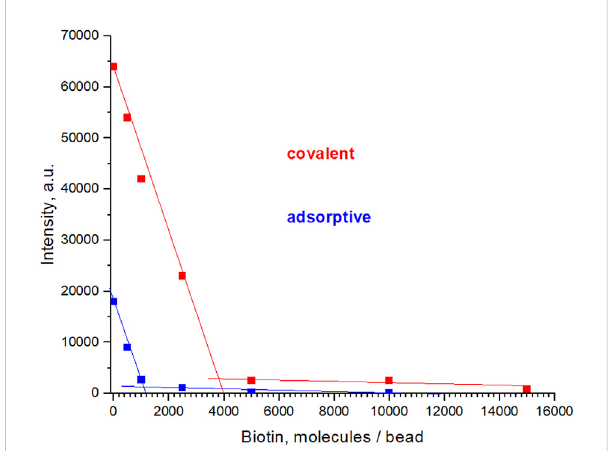
Fluorescence “ Microscopy-Titration ” : Results from lightness evaluation of the Biotin-testline of Lateral Flow strips after blocking theadherenceoftheanalyte(Neutravidin)withincreasingadditions of Biotine prior to the chromatography. Both, Neutravidin covalently and adsorptively coupled are represented. Each data point corresponds to one individual chromatography experiment. Samples evaluated were core-shell particles after method 1. Microscope settings: excitation at 365 nm, emission 610 nm, 6% LED power, exposure time 50 ms. Further details on microscope and chemical procedures are given in the